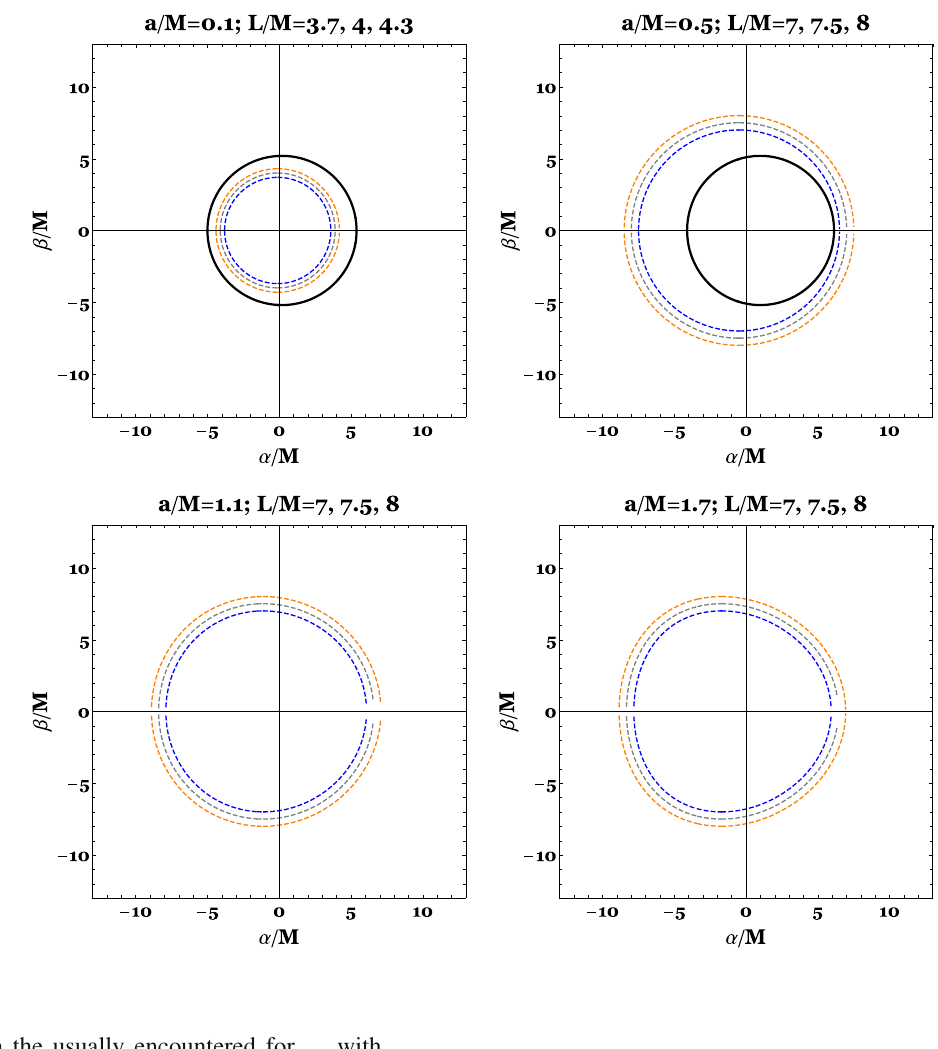
Fig. 1 Silhouette of the shadow cast by the rotating polytropic BH for a / M = 0 . 1 (left upper panel) with L / M = 3 . 7 (blue line) L / M = 4 (gray line) L / M = 4 . 3 (orange line) and a / M = 0 . 5 (right upper panel), a / M = 1 . 1 (left down panel) and a / M = 1 . 7 (right down panel) with L / M = 7 (blue line), L / M = 7 . 5 (gray line) and L / M = 8 (orange line). The black solid line in the plots of the upper row corresponds to the shadow of the Kerr